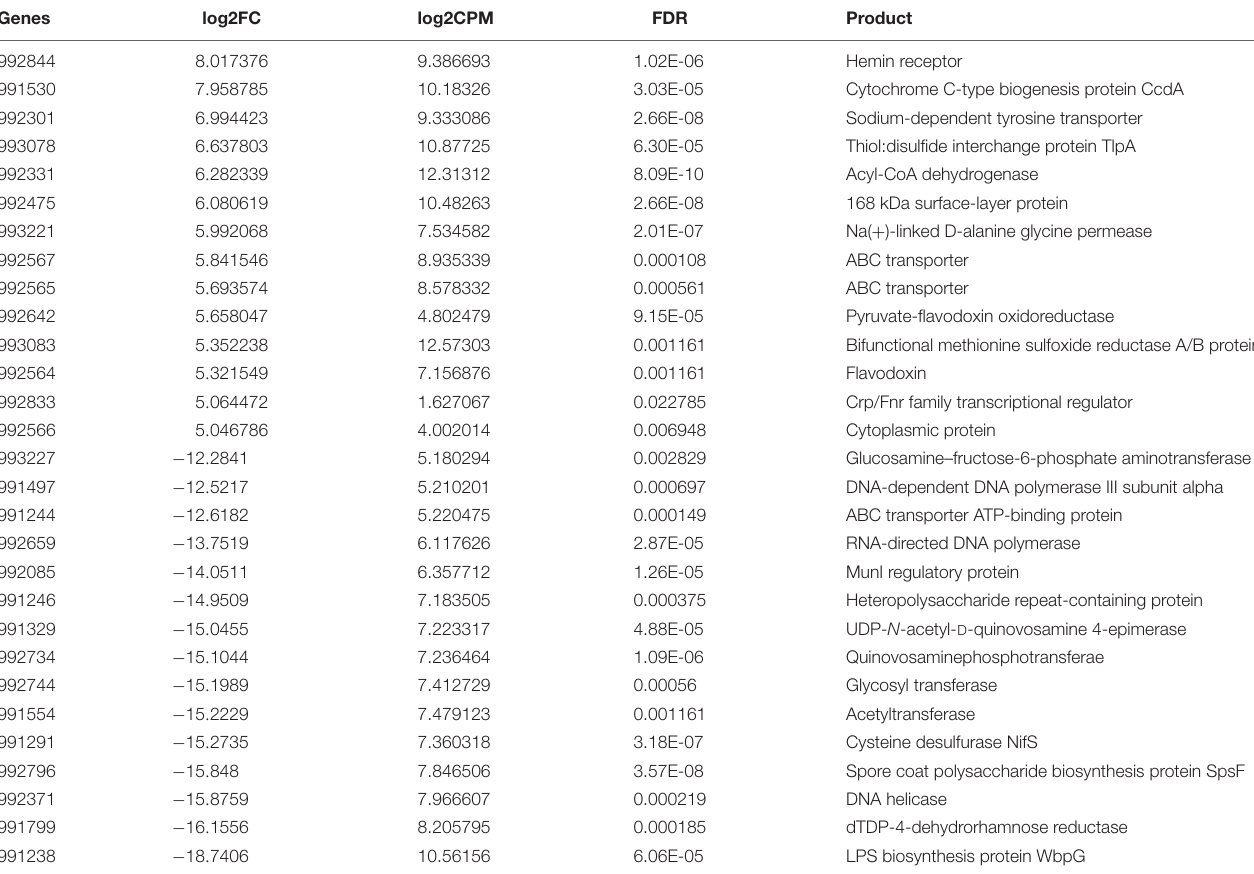
TABLE 5 | Differentially expressed genes (15 most up- and down-regulated in periodontal pocket) between periodontitis and laboratory culture in Fusobacterium nucleatum. Genes log2FC log2CPM